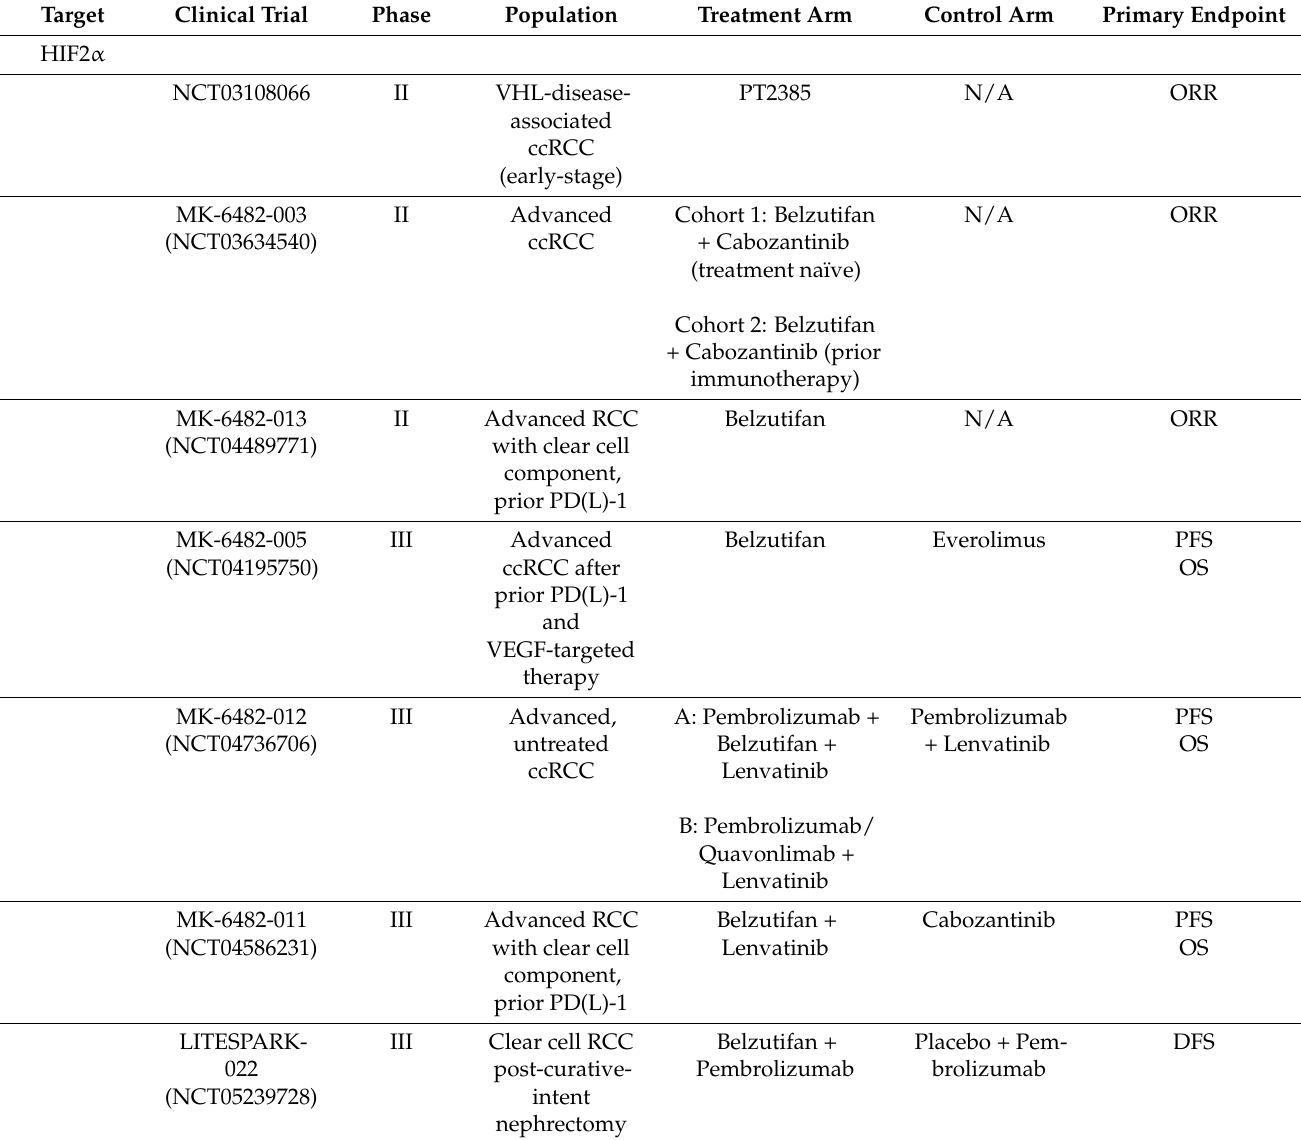
Table 1. Summary of active phase II and III trials evaluating novel therapeutic targets in